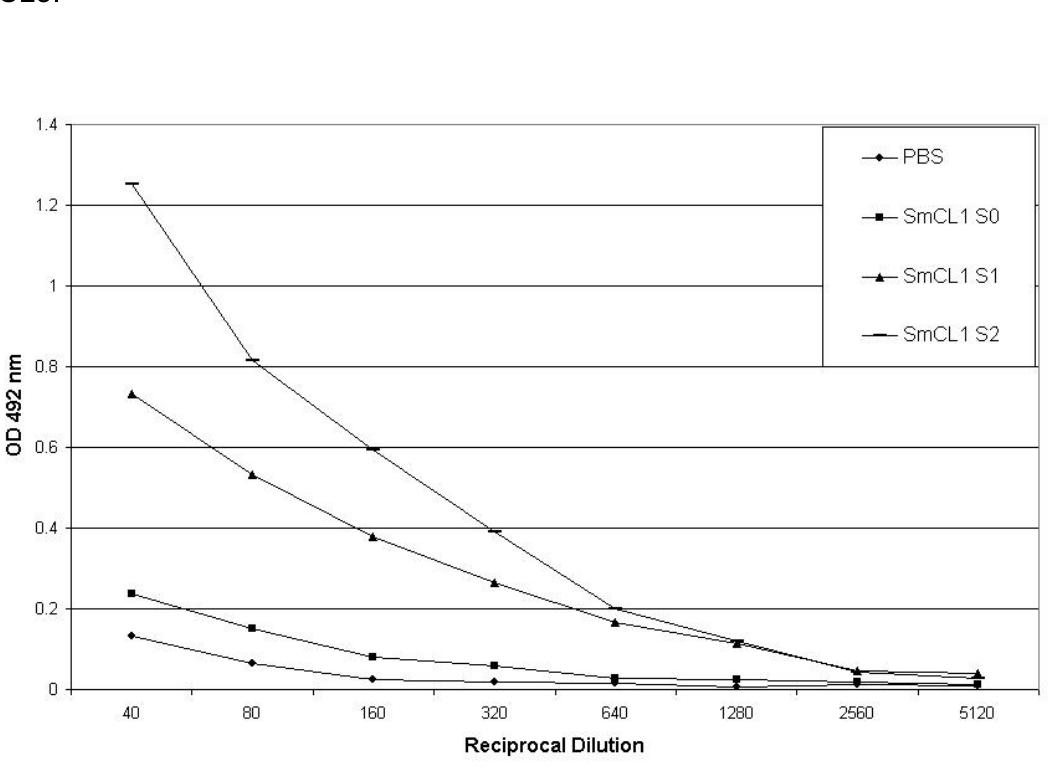
Figure 2. Antibody responses induced by recombinant SmCL1. Swiss mice received footpad immunization, in intervals of seven days, that comprised three 20- μ g doses of recombinant protein (SmCL1) in PBS adsorbed in aluminum hydroxide. Control mice were injected with PBS in aluminum hydroxide. One day before the first and the last immunization, as well as before challenge, mice were bled from the retro-orbital plexus and pooled sera were analyzed by ELISA. PBS: sera collected from mice injected with PBS; SmCL1 S0: sera collected from mice before the first immunization; SmCL1 S1: sera collected from immunized mice before the last immunization; SmCL1 S2: sera collected from immunized mice before the challenge with S. mansoni